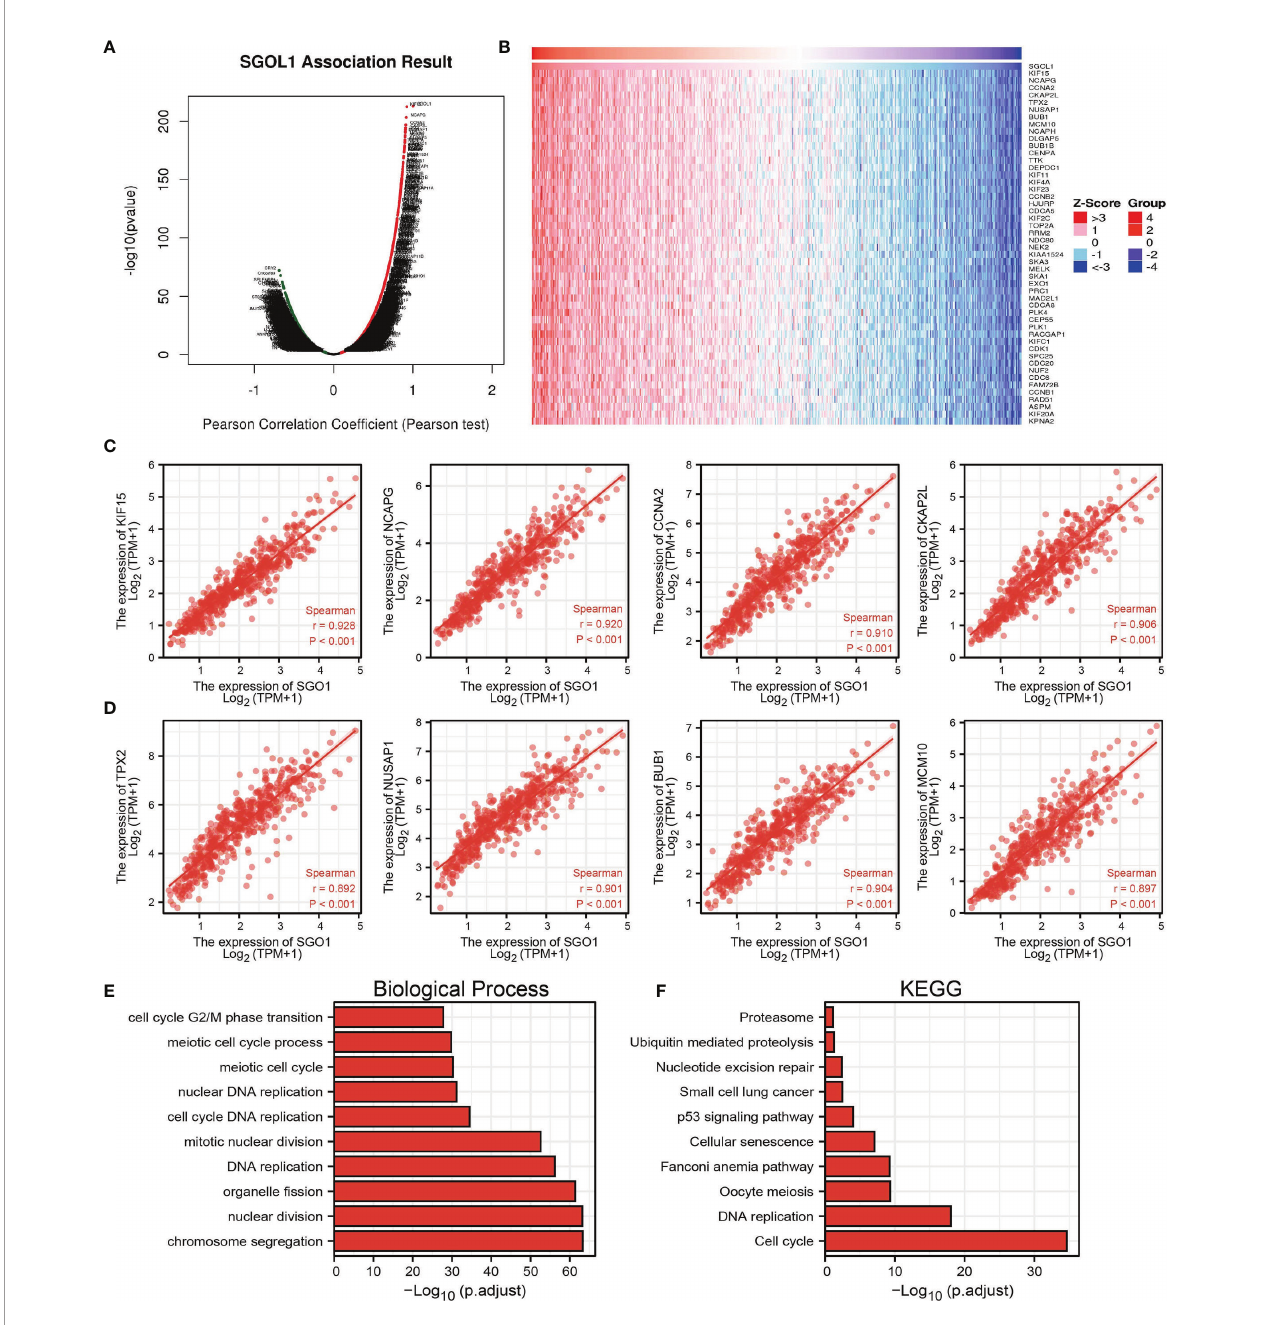
FIGURE 6 | KEGG enrichment analysis of SGO1. (A – D) Genes that were signi fi cantly positively correlated with SGO1 expression in LUAD based on our TCGA- LAUD data. (E, F) GO and KEGG enrichment analysis of SGO1 in